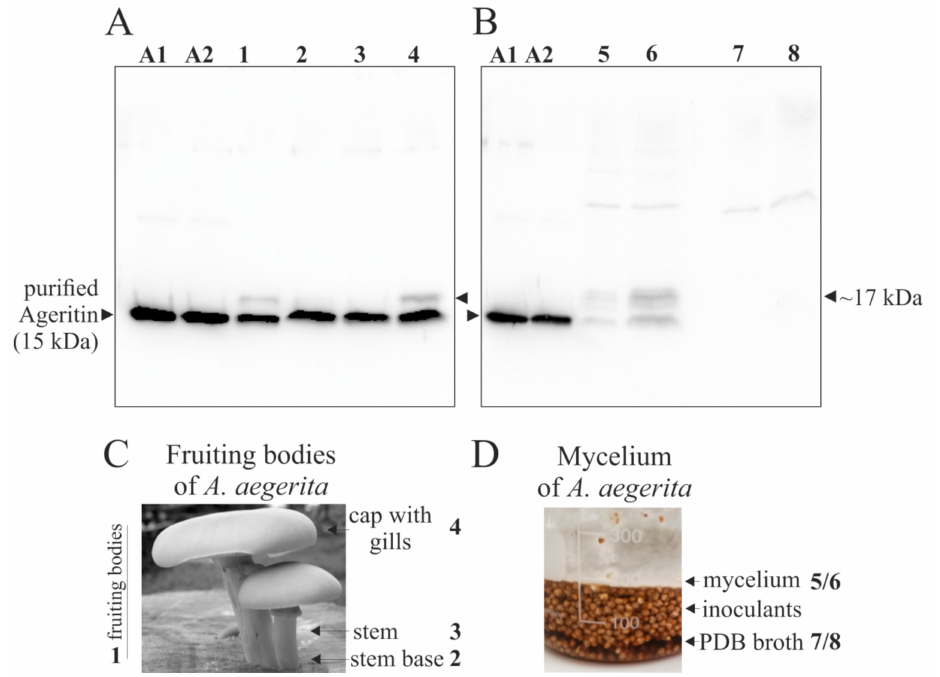
Figure 3. Western blot analysis of proteins extracts from A. aegerita fruiting bodies or mycelim. ( A ) 10 µ g of total proteins extracted from total fruiting bodies were loaded into lane 1, from base steams into lanes 2 and 3 and from cap with gills into lane 4. In ( B ), 10 or 50 µ g of total proteins extracted from mycelium were loaded into lanes 5 and 6, respectively. The same amount of total proteins present in potato dextrose broth (PDB) medium used for mycelia growth were loaded into lanes 7 and 8, respectively. As a control, in both panel A and C, lanes A1 and A2 were loaded with 100 and 50 ng of purified Ageritin, respectively [1]. The samples were separated by SDS-PAGE with β -mercaptoethanol and analyzed by Western blot using the rabbit antiserum antibody against Ageritin. SDS-PAGE was carried out in 15% polyacrylamide separating gel. In ( C , D ), schematic representation of single parts of A. aegerita mushroom and mycelium cultured in PDB medium are